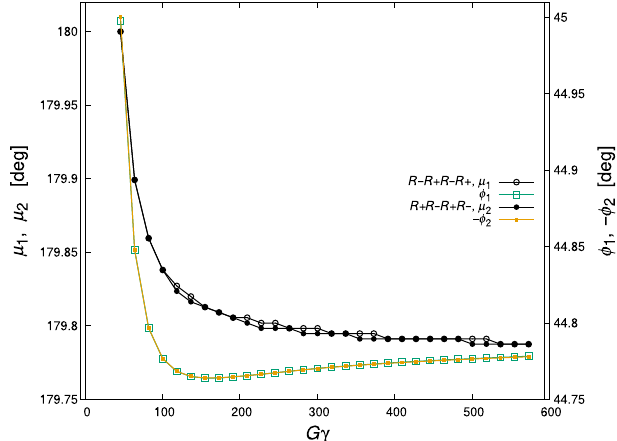
FIG. 9. Energy dependence of R − R þ R − R þ (index 1) and R þ R − R þ R − (index 2) snake series angles, over [23.8, 300] GeV (the solid lines are to guide the eye). The OPERA model currents for precisely μ ¼ 180 ° and ϕ ¼ 45 °